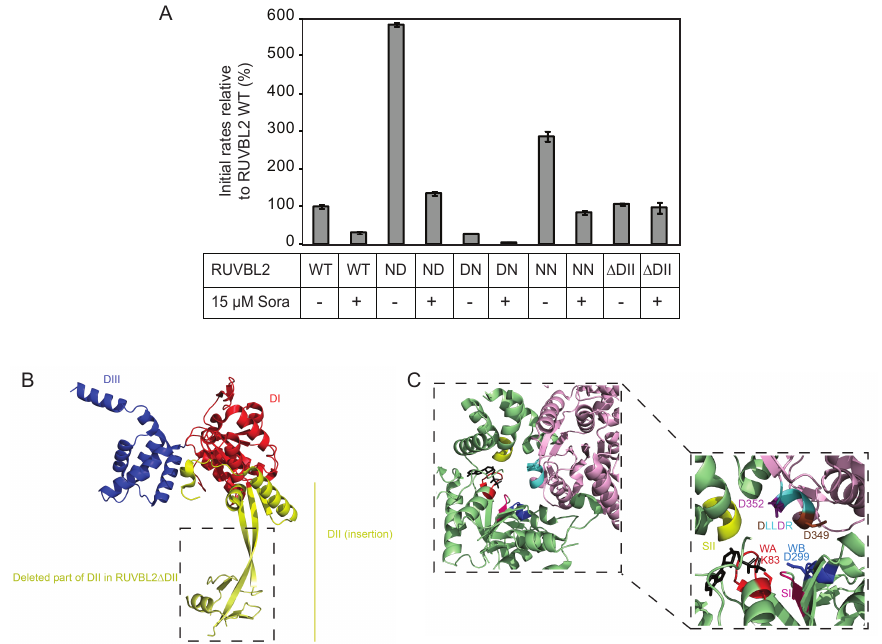
Figure 4. E ff ect of sorafenib on the ATPase activity of RUVBL2 mutants. ( A ) ATPase activities of RUVBL2 WT, with mutations in the DLLDR motif, and with truncation of the DII domain were measured at 10 µ M protomer concentration in the absence and presence of 15 µ M sorafenib. Results shown are the mean of triplicates ± SD. The following are the mutants used, ND: NLLDR; DN: DLLNR; NN: NLLNR. ( B ) Crystal structure of RUVBL2 monomer (PDB: 6H7X). In red is DI, the N-terminal αβα subdomain of the AAA + domain, in blue is DIII, the C-terminal all α subdomain of the AAA + domain, and in yellow is DII, the insertion domain. Boxed is the part of DII that was deleted in RUVBL2 ∆ DII. ( C ) Shown is the ATP-binding pocket at the interface between two RUVBL2 subunits. One subunit is colored in light pink and the adjacent monomer is colored in green (PDB: 3UK6); the ADP molecule is colored in black. Conserved motifs and specific amino acids with significant role in ATP-binding and hydrolysis are colored as follows: Walker A (WA) in red with K83 in stick representation, Walker B (WB) in dark blue with D299 in stick representation, Sensor I in hot pink, Sensor II in yellow, and the DLLDR motif in cyan. The first aspartic acid (D349) in DLLDR is colored in brown and the second aspartic acid (D352) is colored in purple and both are shown in stick